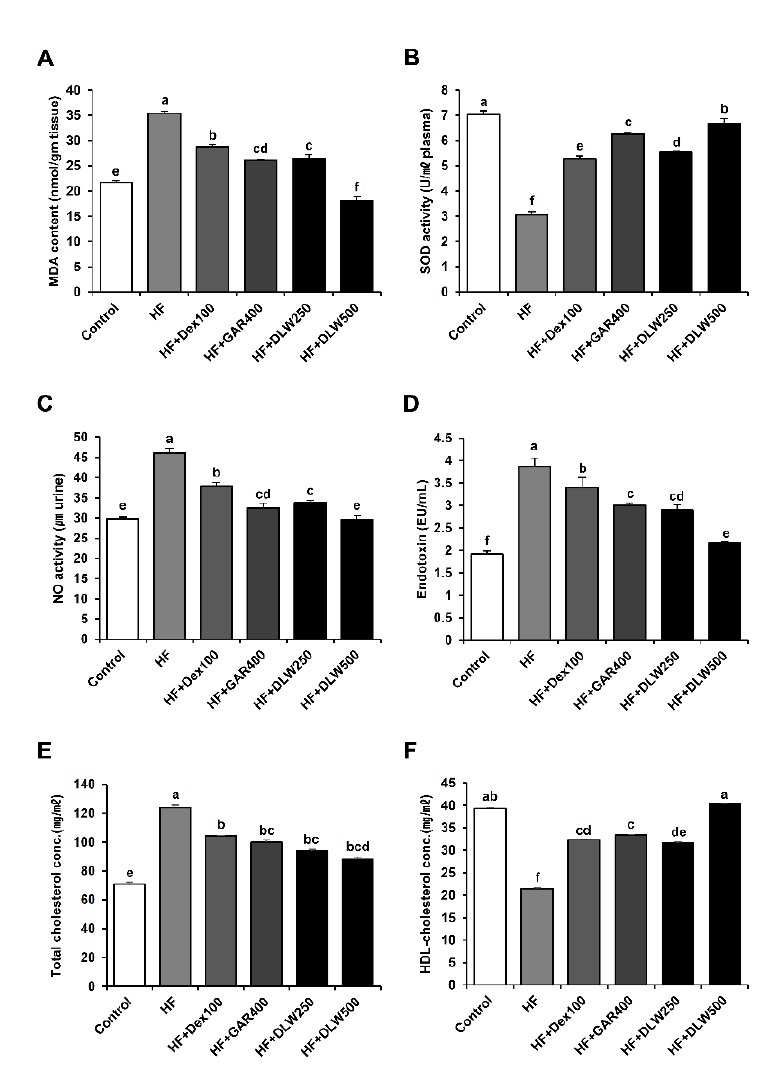
Figure 3. Effects of DLW on relative oxidative stress, cholesterol levels in tissue, serum, urine. MDA and NO activity levels were decreased. SOD activity levels were increased by HF+Dex100, HF+GAR400, HF+DLW250, and HF+DLW500. MDA, SOD, and NO were analyzed in extracts from the liver tissue, plasma, and urine following treatment with HF, HF+Dex100, HF+GAR400, HF+DLW250, and HF+DLW500. Plasma endotoxin concentration (EU/mL) as measured by the LAL assay following treatment with HF, HF+Dex100, HF+GAR400, HF+DLW250, and HF+DLW500. Total cholesterol and HDL cholesterol levels were affected by HF, HF+Dex100, HF+GAR400, HF+DLW250, and HF+DLW500. Total cholesterol and HDL cholesterol were analyzed in extracts from the serum following treatment with HF, HF+Dex100, HF+GAR400, HF+DLW250, and HF+DLW500. ( A ) MDA level. ( B ) SOD activity. ( C ) Nitric Oxide activity. ( D ) Endotoxin level. ( E ) Total cholesterol concentration. ( F ) HDL cholesterol concentration. The values presented are the means ± SD of three independent experiments. Means with different superscript letters are significantly different, p < 0.05. (one-way analysis of variance ANOVA followed by Tukey’s multiple